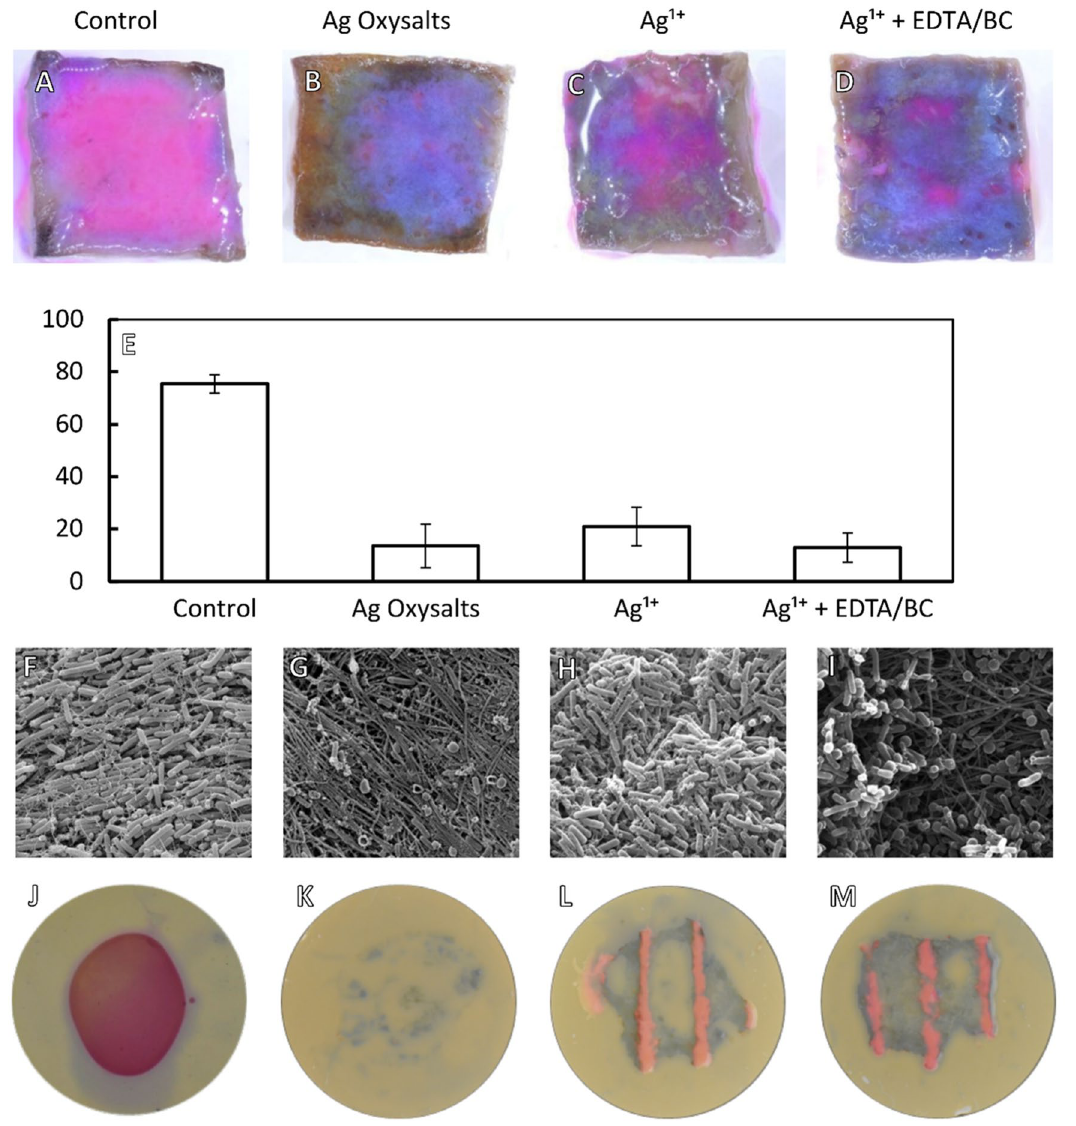
Figure 2. Visualisation of P. aeruginosa biofilms after treatment with silver dressings. ( A – D ) The viability of bacteria within P. aeruginosa biofilms grown on porcine skin were visualised with PrestoBlue viability dye after 24 h treatment with silver dressings or non-antimicrobial control dressings. Viable bacteria appear pink and non-viable bacteria and porcine skin appear blue. ( E ) Viable bacteria (pink staining) were quantified using Image Pro version 10 ( F – I ) Scanning electron microscopy of P. aeruginosa biofilms grown on porcine skin and treated with silver dressings or non-antimicrobial control dressing for 24 h. SEM scale bar = 5 µm. ( J – M ) Colony biofilms grown on filter membranes and stained with PrestoBlue viability dye following 24 h incubation with silver (Fig. 3O). Additionally, a modest reduction in wound area was noted in the Ag 1+ treated group (2.4mm 2 ), and wounds treated with Ag 1+ + EDTA/BC dressings failing to reduce wound area (2.9mm 2 ). Ag Oxysalts also pro- moted re-epithelialisation of S. aureus biofilm-infected wounds (31%), to a greater extent than treatment with the non-antimicrobial control dressing (12%, p = 0.003) (Fig. 3P). Ag 1+ dressings (16%, p = 0.903) and Ag +1 + EDTA/ BC (14%, p = 0.965) dressings demonstrated similar levels of reepithelialisation to the control. To visualise the effects of the silver dressings on the biofilm matrix, Toto 1 iodide and Syto 60 staining was performed (Fig. 4). Toto 1 iodide is a cell impermeant dye and can be used to accurately visualise extracel- lular nucleic acids, which are in high quantity in a biofilm EPS. Syto 60 is a cell-permeant dye utilised as a counterstain 16 . Observations of Toto 1 iodide and Syto 60 in P. aeruginosa (Fig. 4A–D) and S. aureus (Fig. 4I–L) biofilm inoculated wounds revealed a visual reduction in extracellular DNA within the biofilm EPS following 3 days treatment with dressings containing Ag Oxysalts and Ag 1+ + EDTA/BC. Ag 1+ dressings which contain